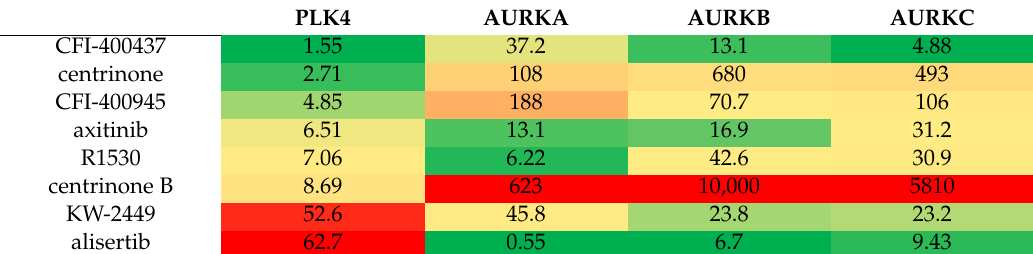
Table 3. Half maximal inhibitory concentrations (IC 50 nM) of each inhibitor on the activity of PLK4, AURKA, AURKB, and AURKC. Green—lowest IC 50 ; Red—highest IC 50 .